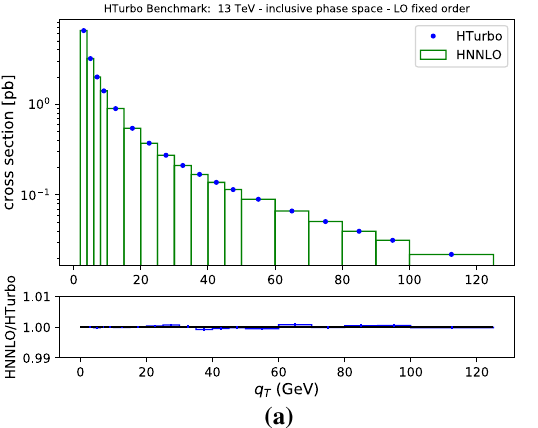
√ s = 13 TeV. Fixed-order